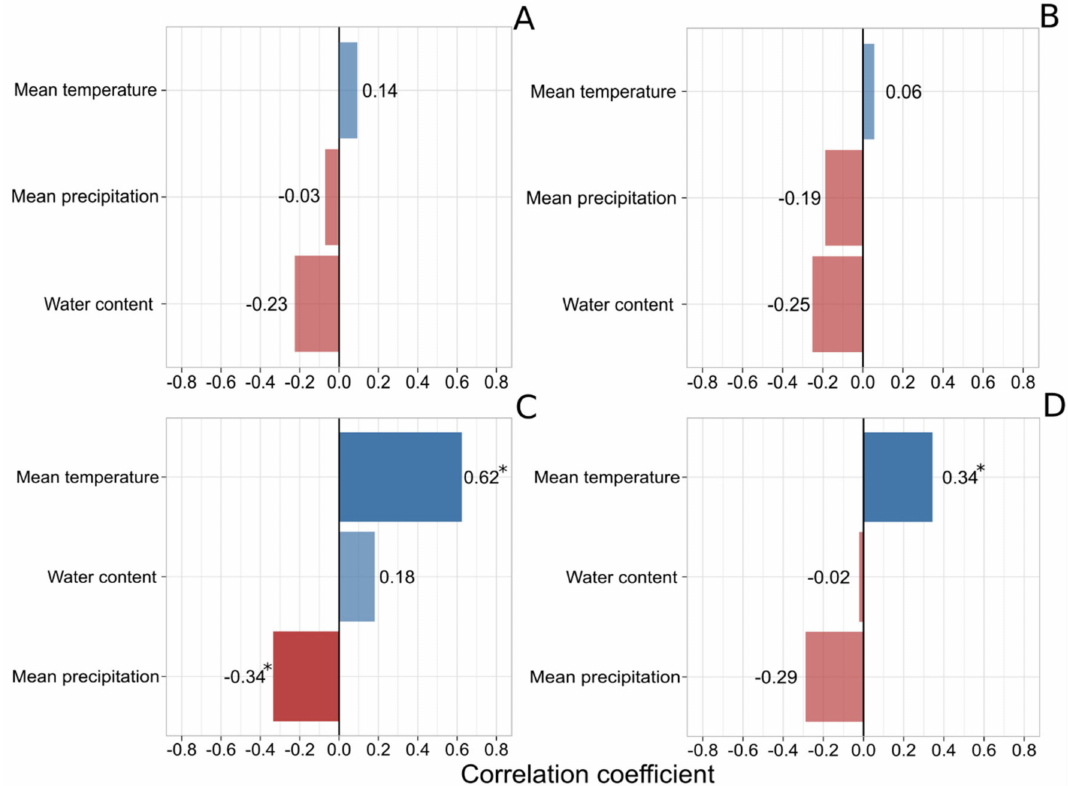
Figure 5. Correlations of proline content with tested parameters: biweekly mean temperature, water content, and biweekly mean precipitation for embryonic axes ( A ) and cotyledons ( B ) of Norway maple seeds, and embryonic axes ( C ) and cotyledons ( D ) of sycamore seeds. Columns marked “*” show significant correlation at p -value ≤ 0.05. Data are the means of three samples, ±